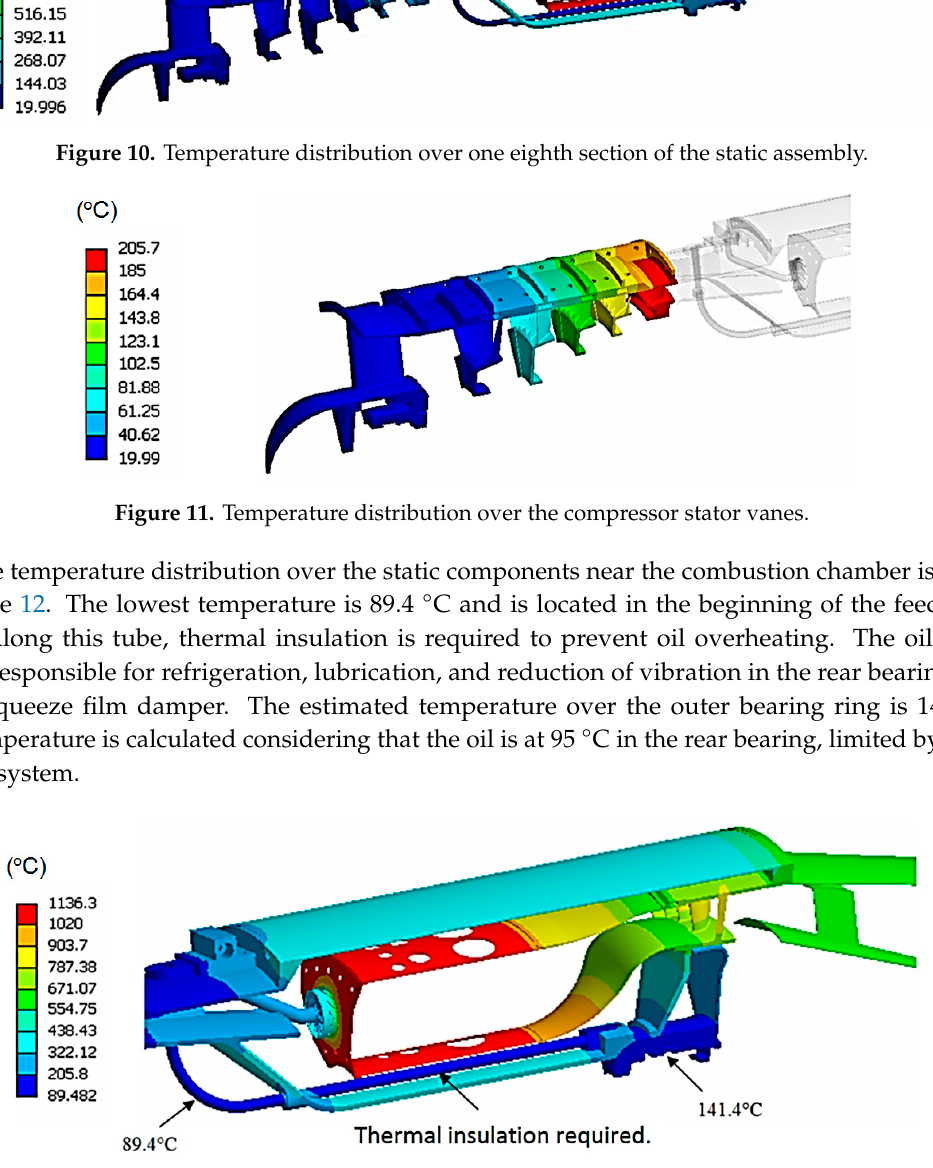
Figure 13. Thermal expansion along the rotating assembly.